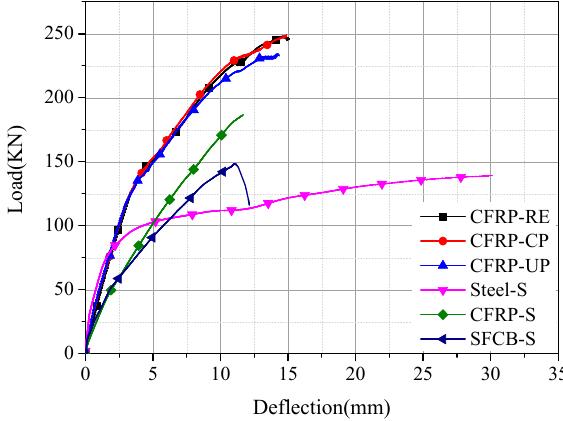
Figure 11. Load-deflection curves for the hybrid-reinforced beams with CFRP bar.